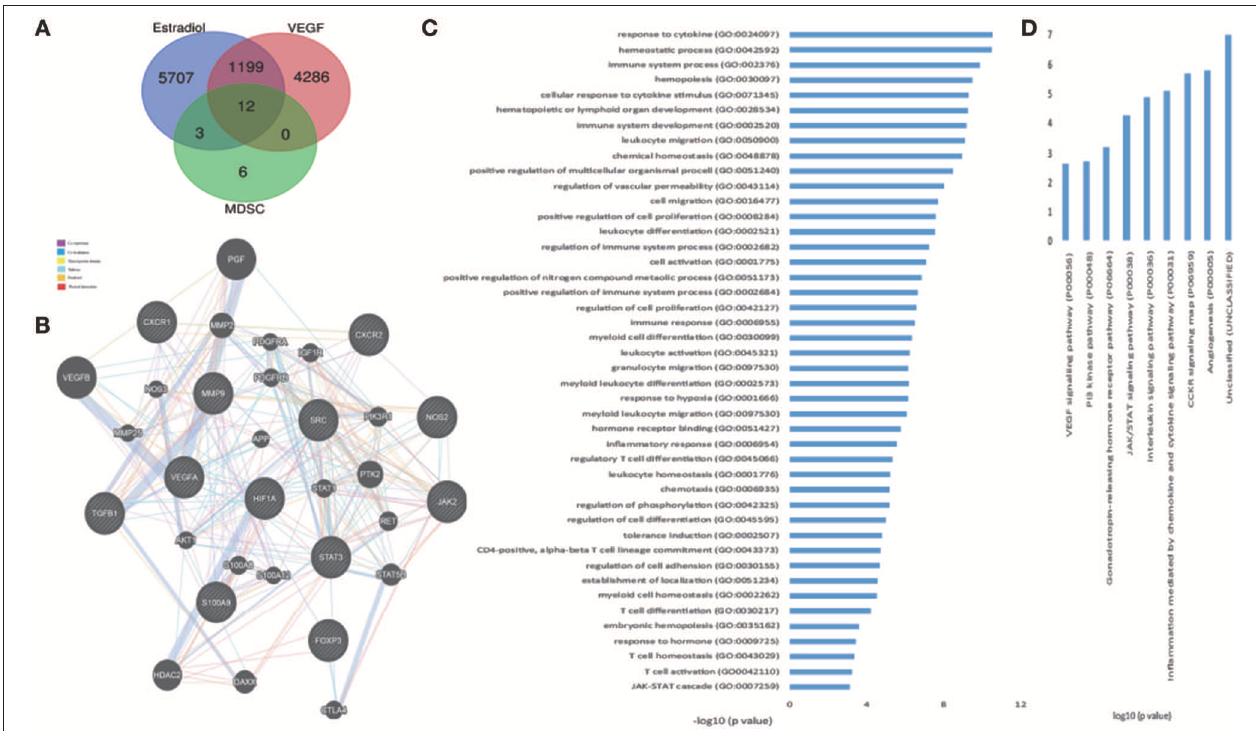
FIGURE 5 | Hub genes of estradiol, VEGF, and MDSC, and bioinformatic analysis of the genes. (A) Venn diagrams of estradiol, VEGF, and functional genes in MDSC as hub genes. (B) Network of hub genes. Black protein nodes indicate target proteins, and different connecting colors represent different correlations. Functional association of targets was analyzed using GeneMANIA. Genes in black circles were submitted as query terms in searches. Gray circles indicate genes associated with query genes. (C) GO analysis of targets. The y-axis shows significantly enriched biological process categories of the targets, and the x-axis shows the enrichment scores of these terms (* p < 0.05). (D) Pathway analysis of targets. The y-axis shows significantly enriched pathway of the targets, and the x-axis shows the enrichment scores of these terms (* p < 0.05).